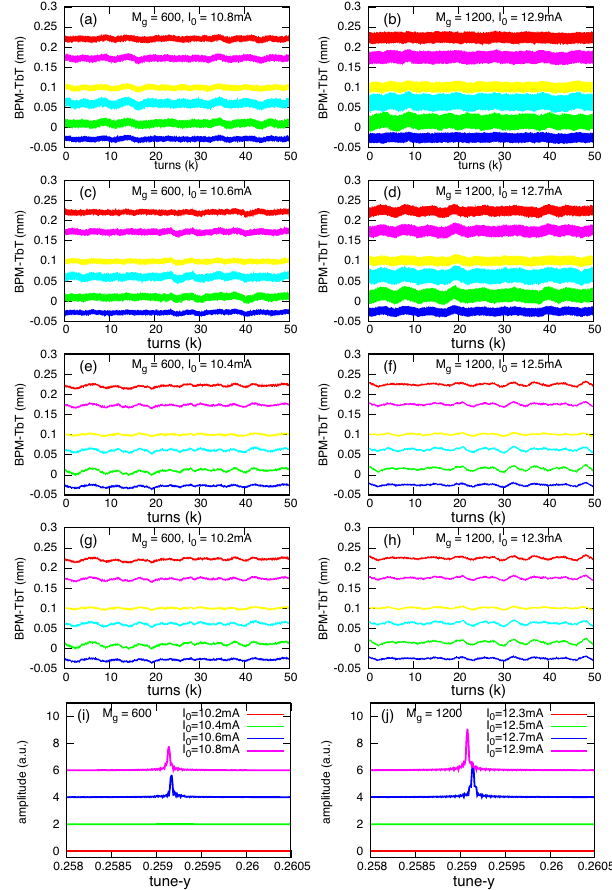
FIG. 5. Measurements at different average currents for the case M M − g ¼ 600 (left frames) and M M − g ¼ 1200 (right g ¼ g ¼ frames), where g is the gap in the maximal ( M ¼ 1320 ) uniform filling pattern. (a) – (h) time evolution of the average bunch centroid position over 50 K turns, as detected from 6 of the 180 regular BPMs distributed around the NSLS-II storage ring. (a) – (d) and (e) – (h) showing unstable and stable betatron motion respectively. (i) and (j): average spectra of the time domain BPM measurements showing the transition from stable to unstable motion.